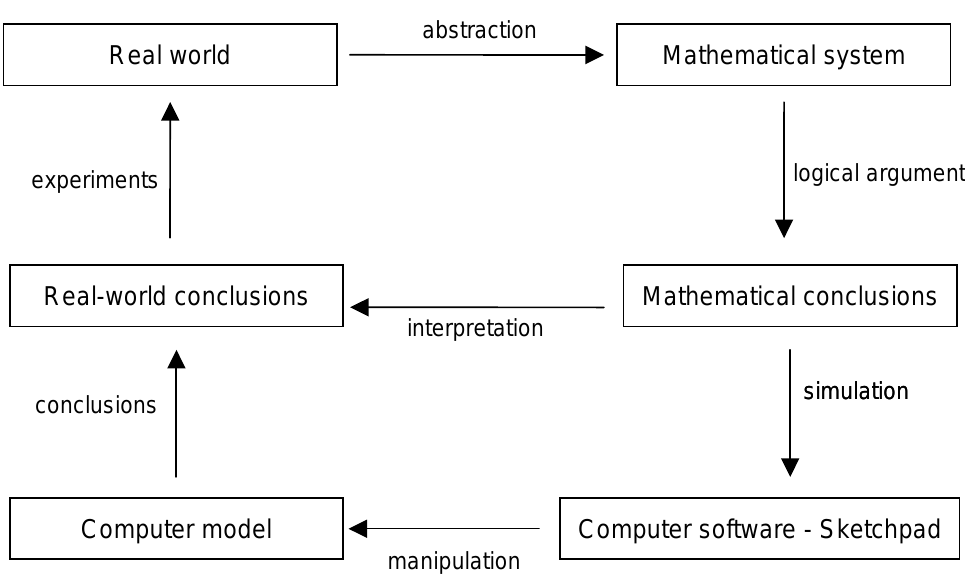
Figure 2. Sketchpad modelling